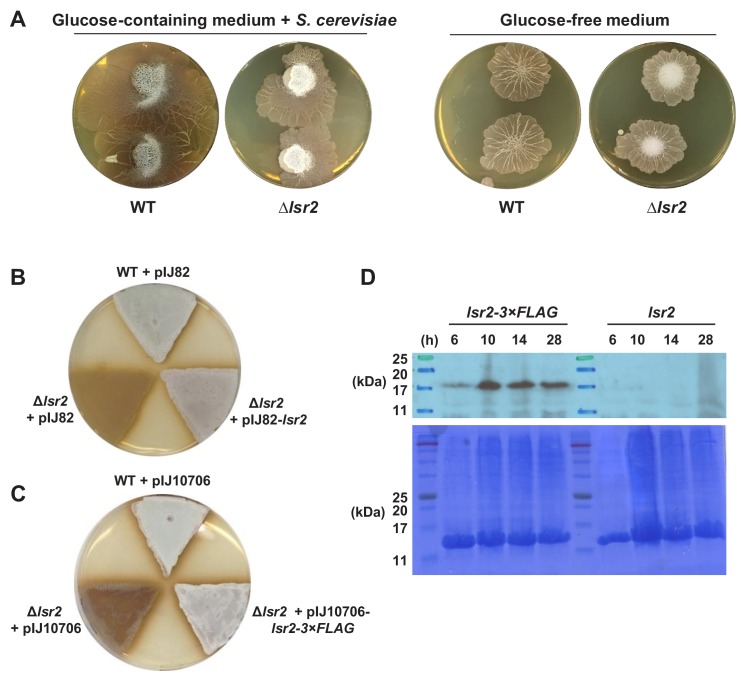
Phenotypic comparison of lsr2 deletion mutants with wild-type S. venezuelae.(A) Wild type and Δlsr2 strains exploring on glucose-containing medium (YPD) in association with yeast (left), or on glucose-free (YP) medium without yeast (right). (B) Phenotype of wild-type S. venezuelae carrying the empty vector pIJ82 (top), the lsr2 null mutant carrying the empty vector pIJ82 (bottom left), or complemented with the native lsr2 (bottom right). Equivalent numbers of spores were grown on MYM solid agar and images were taken after 24 hr. (C) Phenotype of wild-type S. venezuelae carrying the empty plasmid pIJ10706 (top), the lsr2 null mutant carrying the same plasmid (bottom left), or complemented with a C-terminally triple FLAG-tagged lsr2 fusion (bottom right). As for (A), images were taken after 24 hr growth on MYM solid agar. (D) Top panel: western blot analysis of the S. venezuelae lsr2 mutant strain complemented with either the wild type lsr2 gene (right) or the lsr2−3 × FLAG fusion (left). Protein extracts were prepared after 6, 10, 14 and 28 hr growth in MYM broth. Bottom panel: Coomassie staining of equivalent samples to those used for western blotting, was used to control for differential sample loading. Protein size markers (BLUeye, Sigma) are shown with relevant molecular masses annotated in kDa.